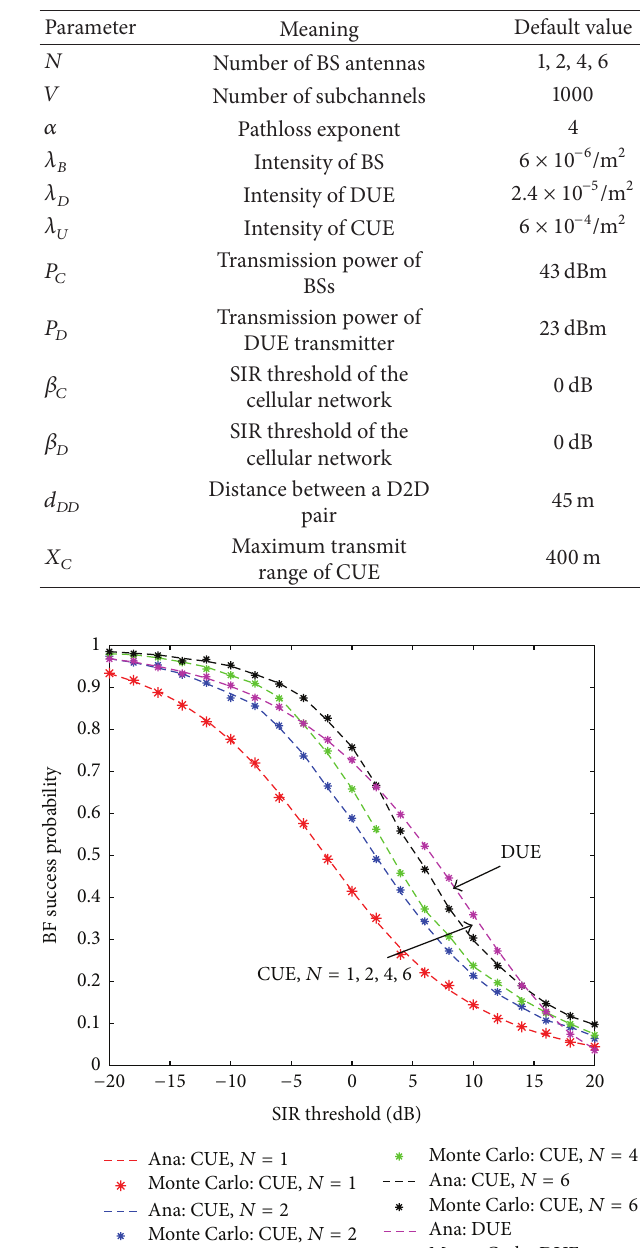
Figure 2: Cellular and D2D communication success probability in BF